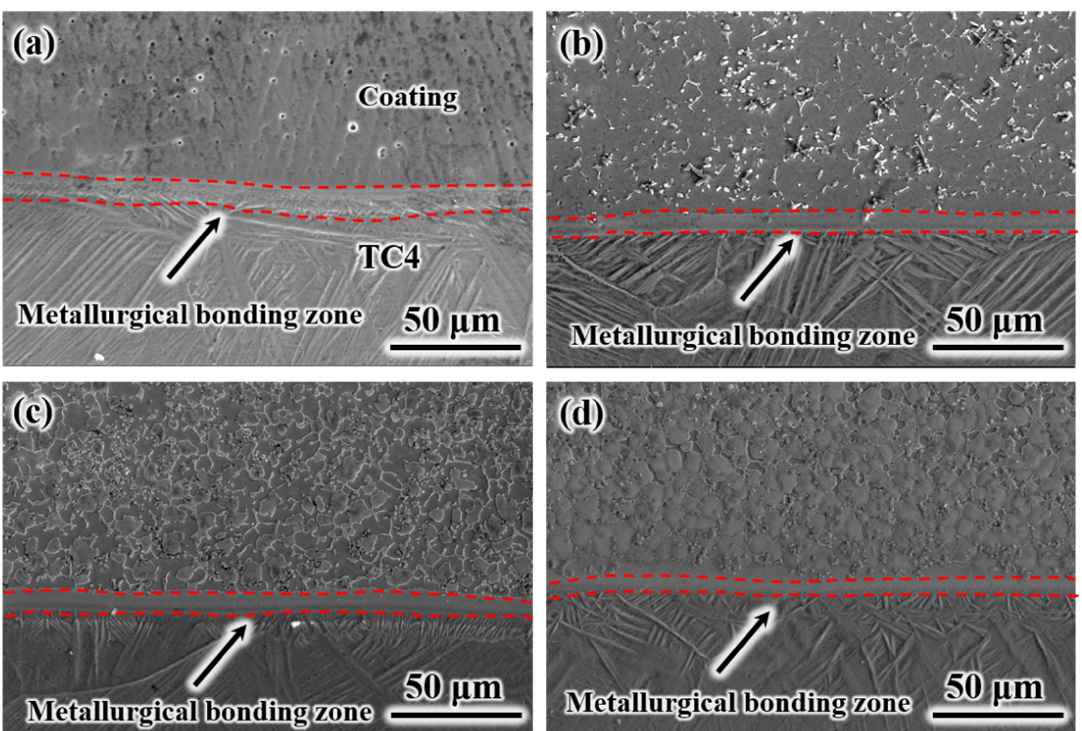
Figure 2. Cross ‐ sectional SEM images of bonding area between the Ti–48Al–2Cr–2Nb composite Figure 2. Cross-sectional SEM images of bonding area between the Ti–48Al–2Cr–2Nb composite coatings and substrate: ( a ) 0 WC; ( b ) 5 WC; ( c ) 10 WC; ( d ) 15 WC. coatings and substrate: ( a ) 0 WC; ( b ) 5 WC; ( c ) 10 WC; ( d ) 15